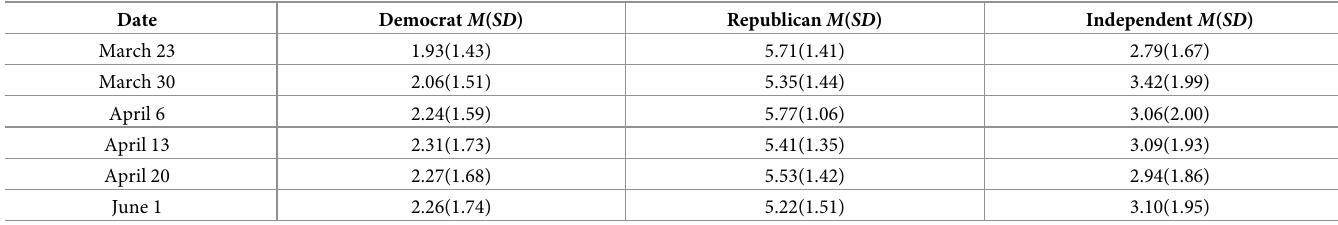
Table 1. Trump support as a function of date and political